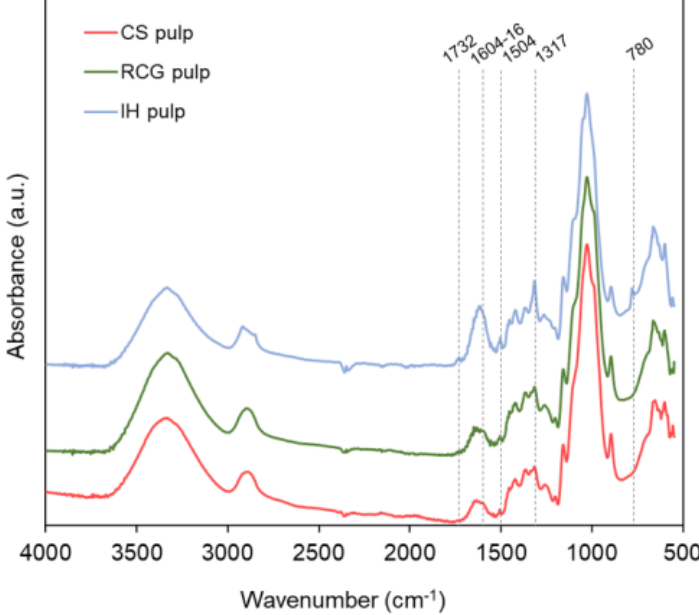
Figure 5. FTIR spectra showing specific chemical bonds of pulps of different biomass feedstocks.